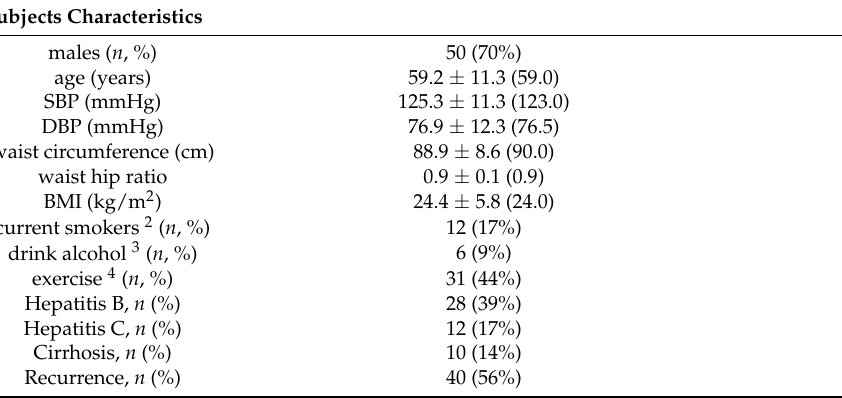
Table 1. Characteristics and dietary intake of subjects 1